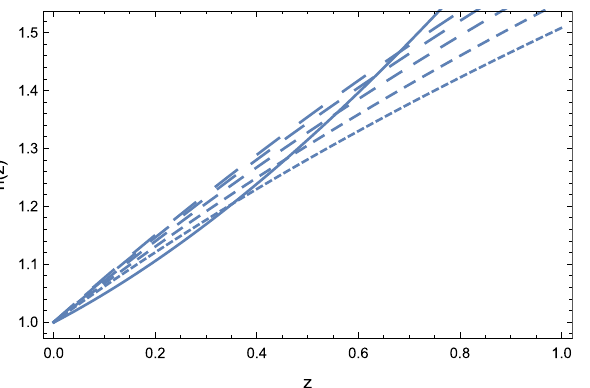
Fig. 2 Variation of the matter-energy density ρ as a function of the redshift z in the f ( Q , T ) gravity theory for f ( Q , T ) = − α Q − β T 2 andforadustUniverse,fordifferentvaluesoftheparameter λ : λ = 1 . 52 (dottedcurve), λ = 1 . 64(shortdashedcurve), λ = 1 . 75(dashedcurve), λ = 1 . 83 (long dashed curve), and λ = 1 . 88 (ultra long dashed curve), respectively. The variation of the matter energy density in the standard (cid:4) CDM model is also represented as the solid